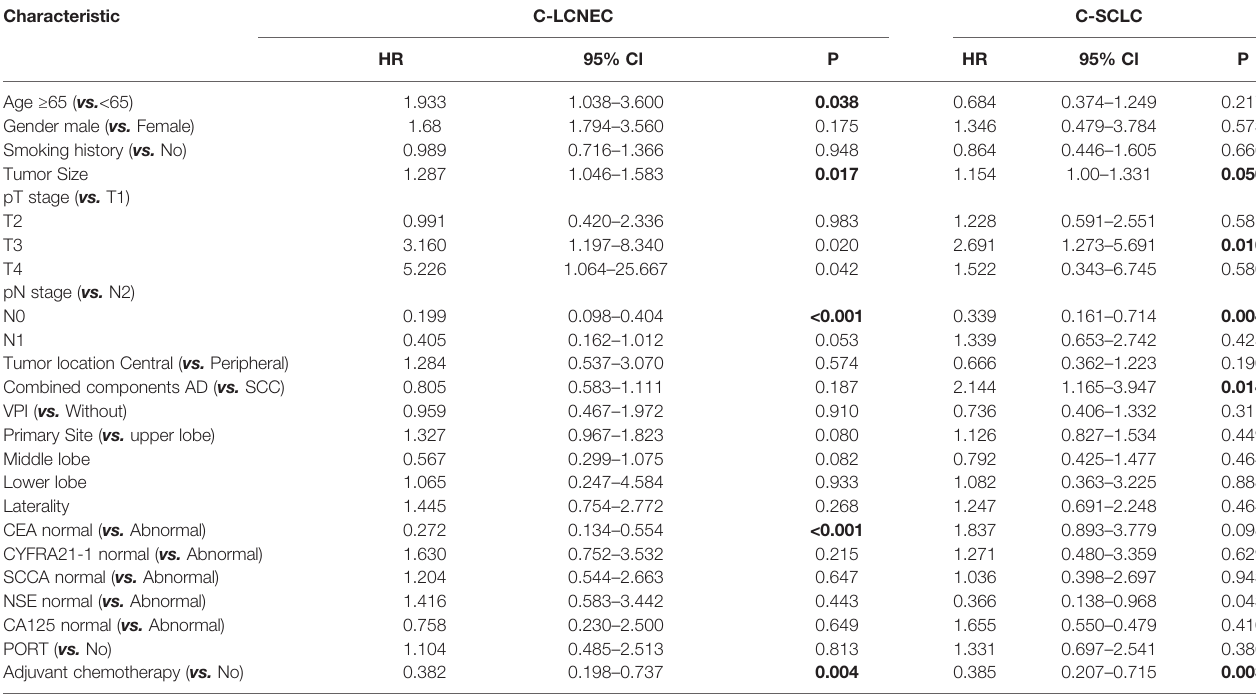
TABLE 3 | Impact of clinical characteristics on overall survival in patients with resected C-LCNEC and C-SCLC by univariate analysis. Characteristic